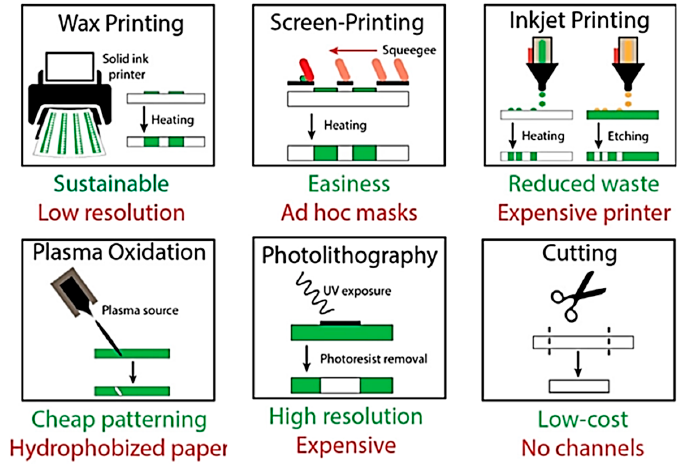
Figure 4. Types of fabrication methods to construct lab ‐ on ‐ chip devices (Adapted with the permission from Elsevier) [28].